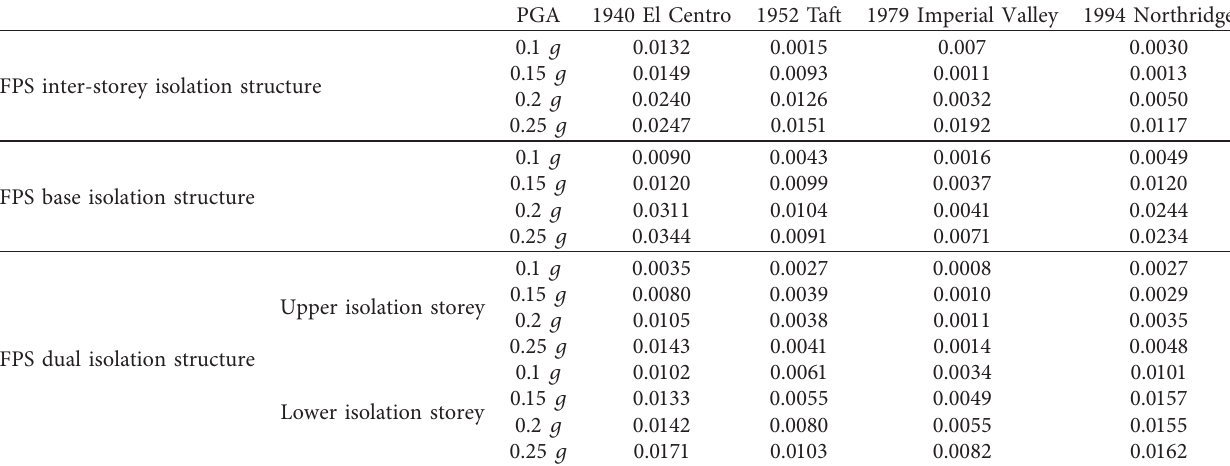
Table 5: Peak displacements of the FPS